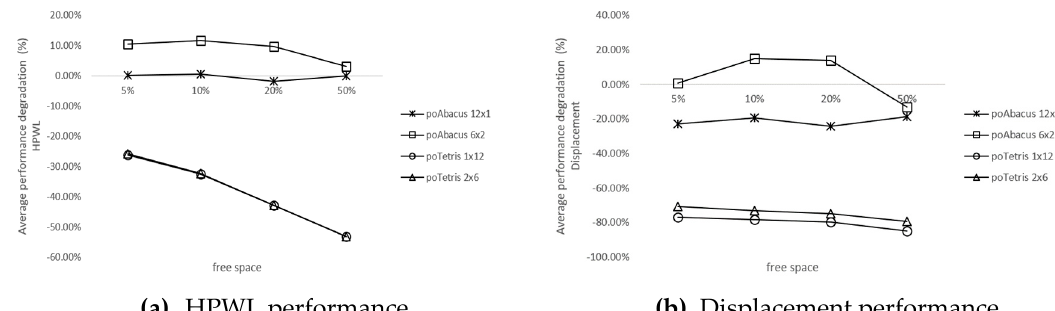
Figure 7. Solution quality performance comparison for different free space percentages.